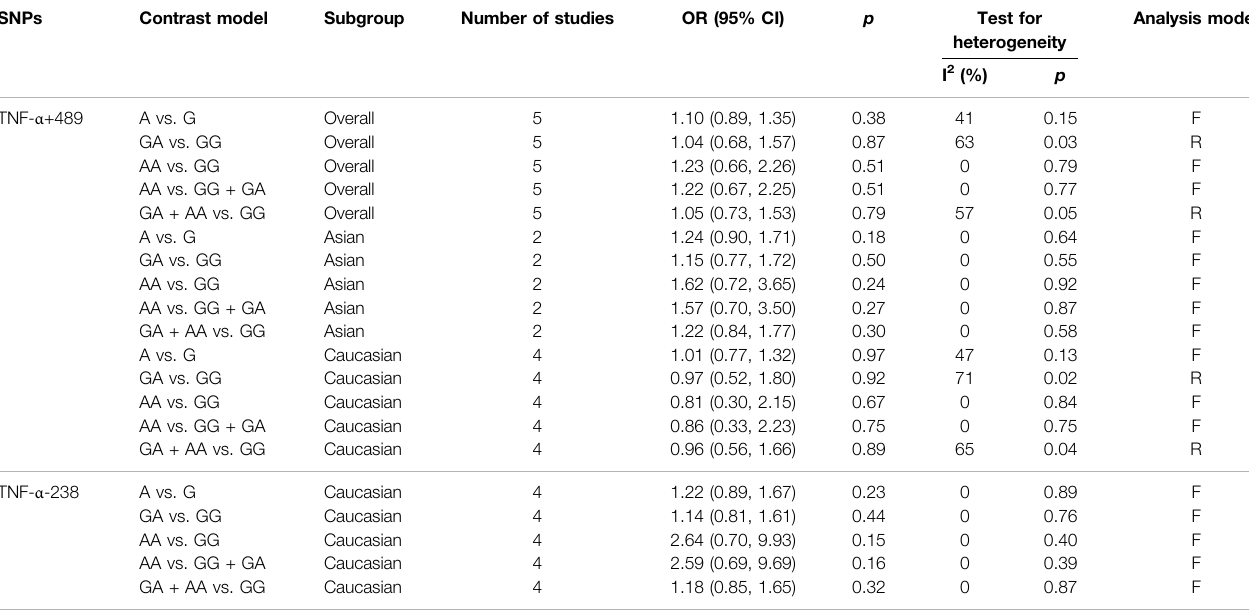
TABLE 3 | Meta-analysis results for relationship between the TNF- α +489, -238 polymorphism and COPD risk. SNPs Contrast model